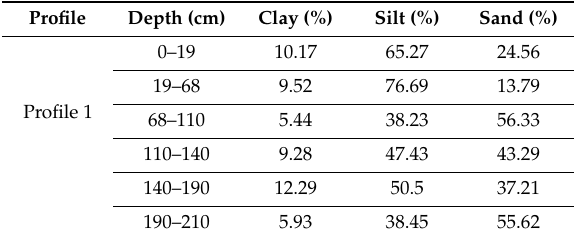
Table 1. The particle size analysis of the soil profiles by depth